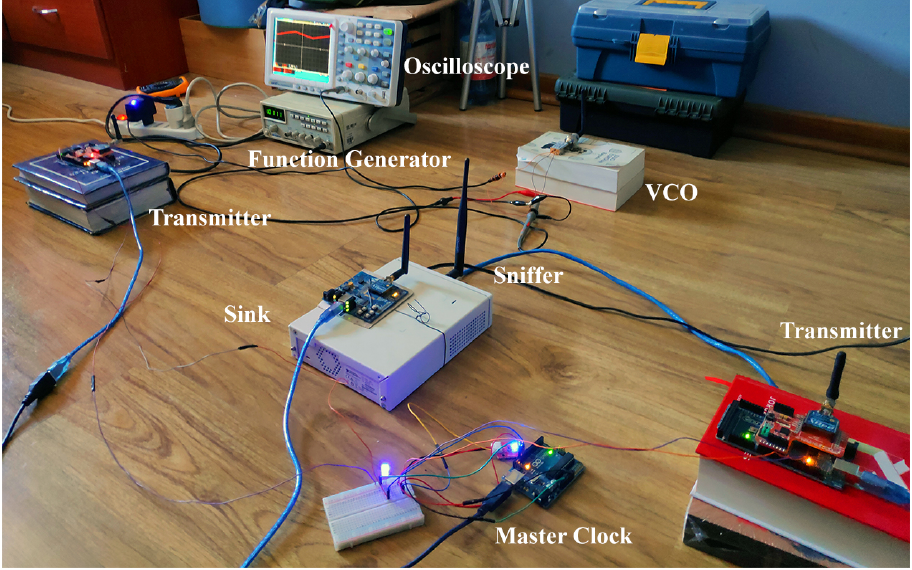
Figure 4. Network devices and instruments are used to obtain experimental data in the indoor environment that consists of a typical